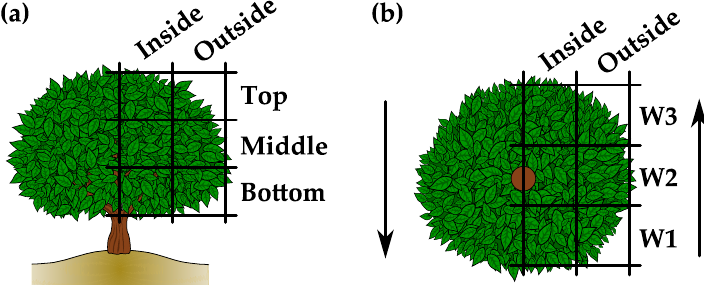
Figure 2. Sections of the canopy considered for average leaf area density ( LAD t ) estimation. ( a ) Side view across the row and ( b ) top view of a standard citrus tree. Arrows indicate the forward direction of the sprayer.